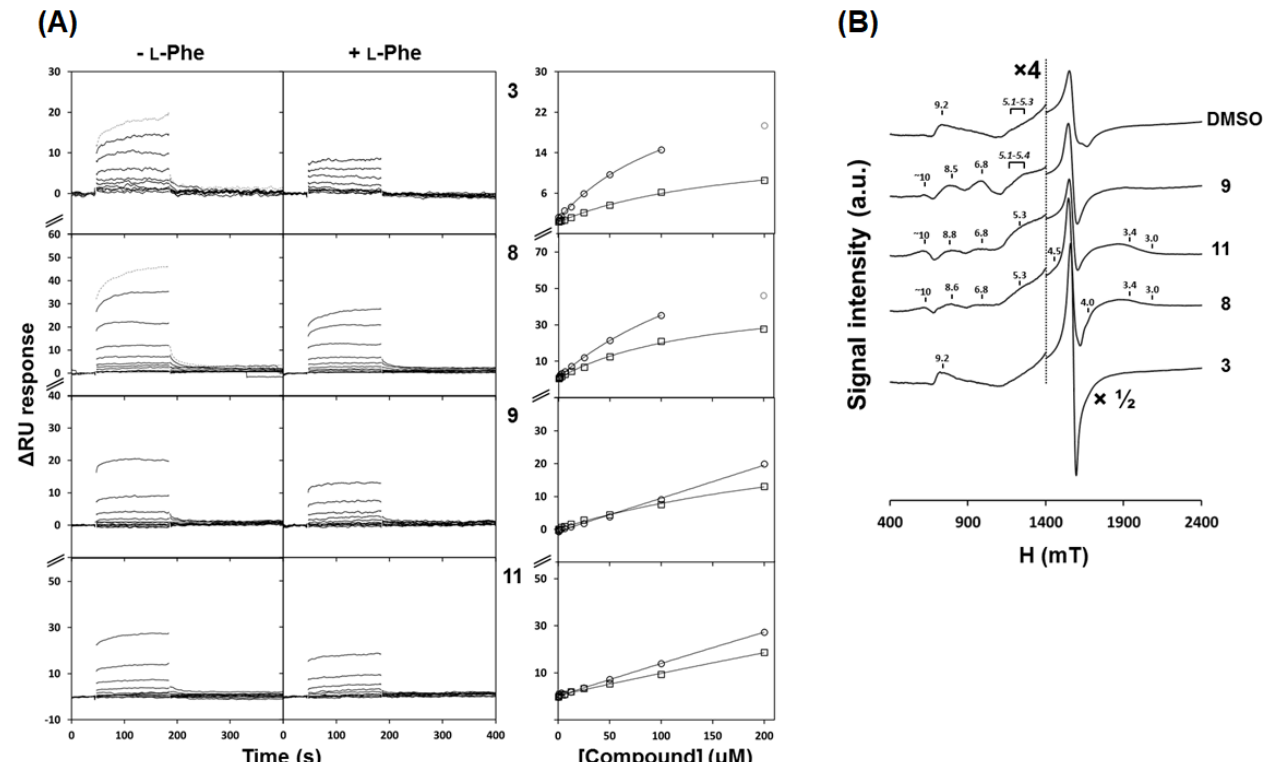
Figure 5. Effect of selected 3HQ derivatives on human phenylalanine hydroxylase (hPAH) properties (affinity for the substrate and electron paramagnetic resonance (EPR) spectra). ( A ) Affinity of hPAH for selected 3HQ derivatives analyzed by surface plasmon resonance (SPR); left panel shows the sensorgrams for the binding of compounds 3 , 8 , 9 , and 11 , at concentrations from 0.4 to 200 μ M, in the absence (-L-Phe) and presence of 1 mM L-Phe (+L-Phe) in the running buffer; the right panel shows the effect of compound concentration on the apparent equilibrium binding to hPAH tetramers in the absence ( ) and presence of 1 mM L-Phe ( ) in the running buffer. ( B ) EPR spectra, of hPAH in the absence and presence of compounds; hPAH (at ≈ 100 μ M monomer) was mixed with equimolar amounts of 3HQs ( 3 , 8 , 9, and 11 ) and spectra were recorded at 4K in a Bruker EMX spectrometer equipped with an Oxford Instruments ESR-900 continuous flow helium cryostat; microwave frequency: 9.39 GHz; microwave power, 2 mW; modulation amplitude, 1 mT; DMSO was used at 1% concentration.